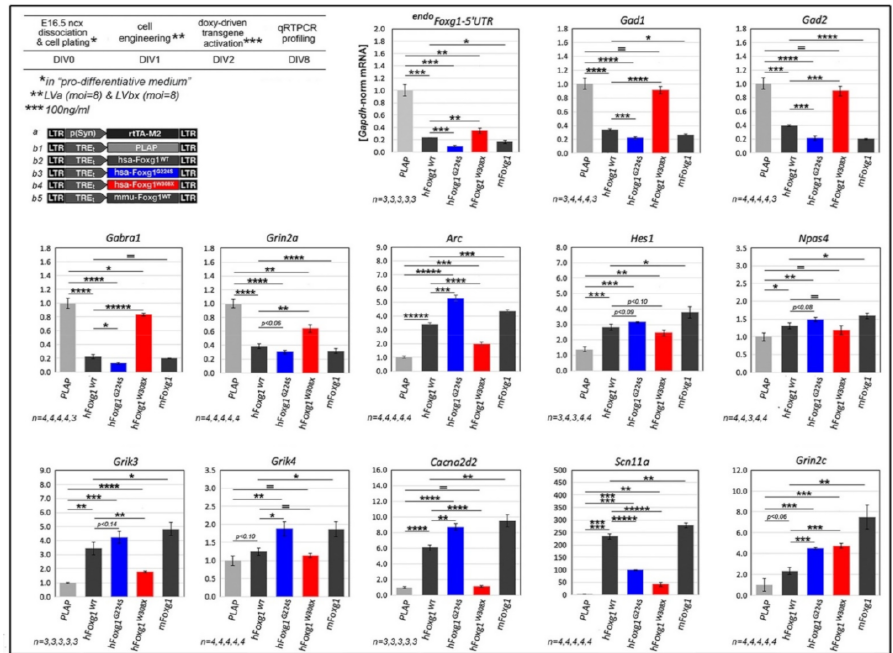
Figure 5. Impact of mutant FOXG1 alleles on neuronal transcriptome, upon lentiviral delivery of transgenes encoding for them to wild-type , murine neuronal cultures. Top-left: protocols and lentiviral vectors employed; bottom-right: qRTPCR results. Data normalized against Plap -expressing controls. Statistical evaluation of results by t -test (one-tailed, unpaired). * p < 0.05, ** p < 0.01, *** p <